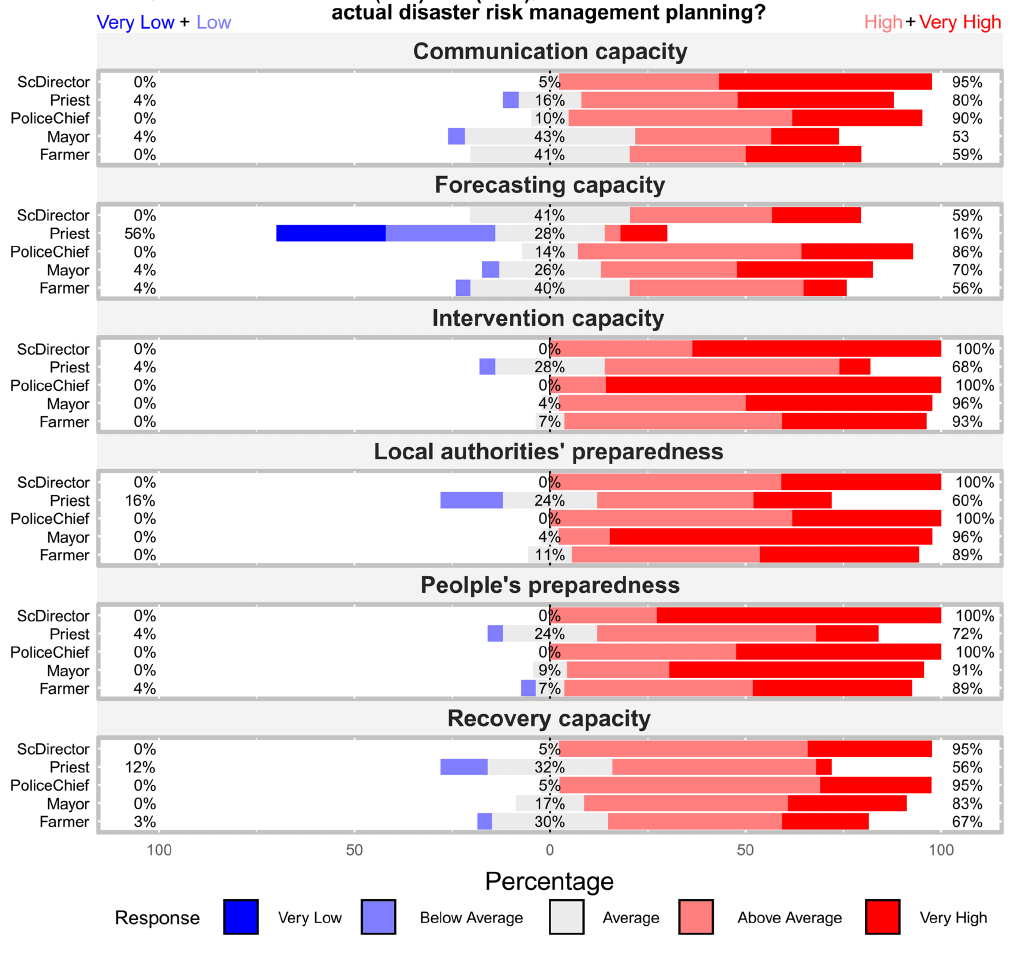
Figure 10. The Likert plot of the stakeholders’ responses regarding the factors which can increase the actual disaster risk management planning.